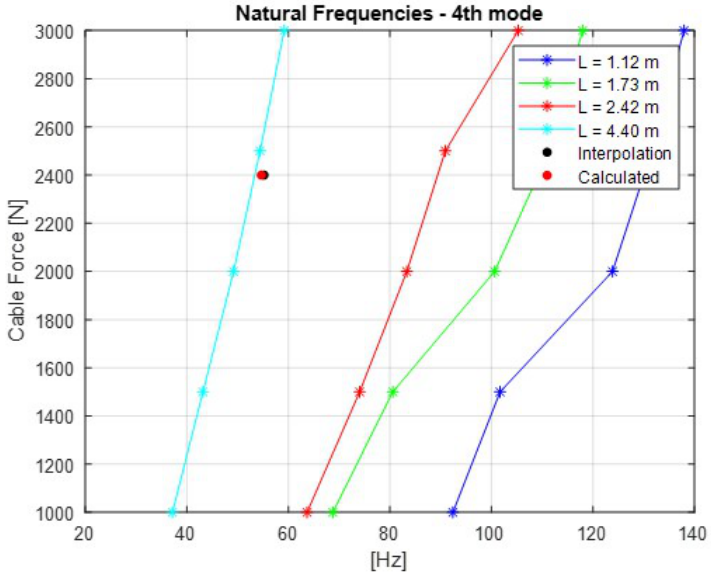
Figure 10. Relationship between the cable force and natural frequencies for the fourth mode of vibration.